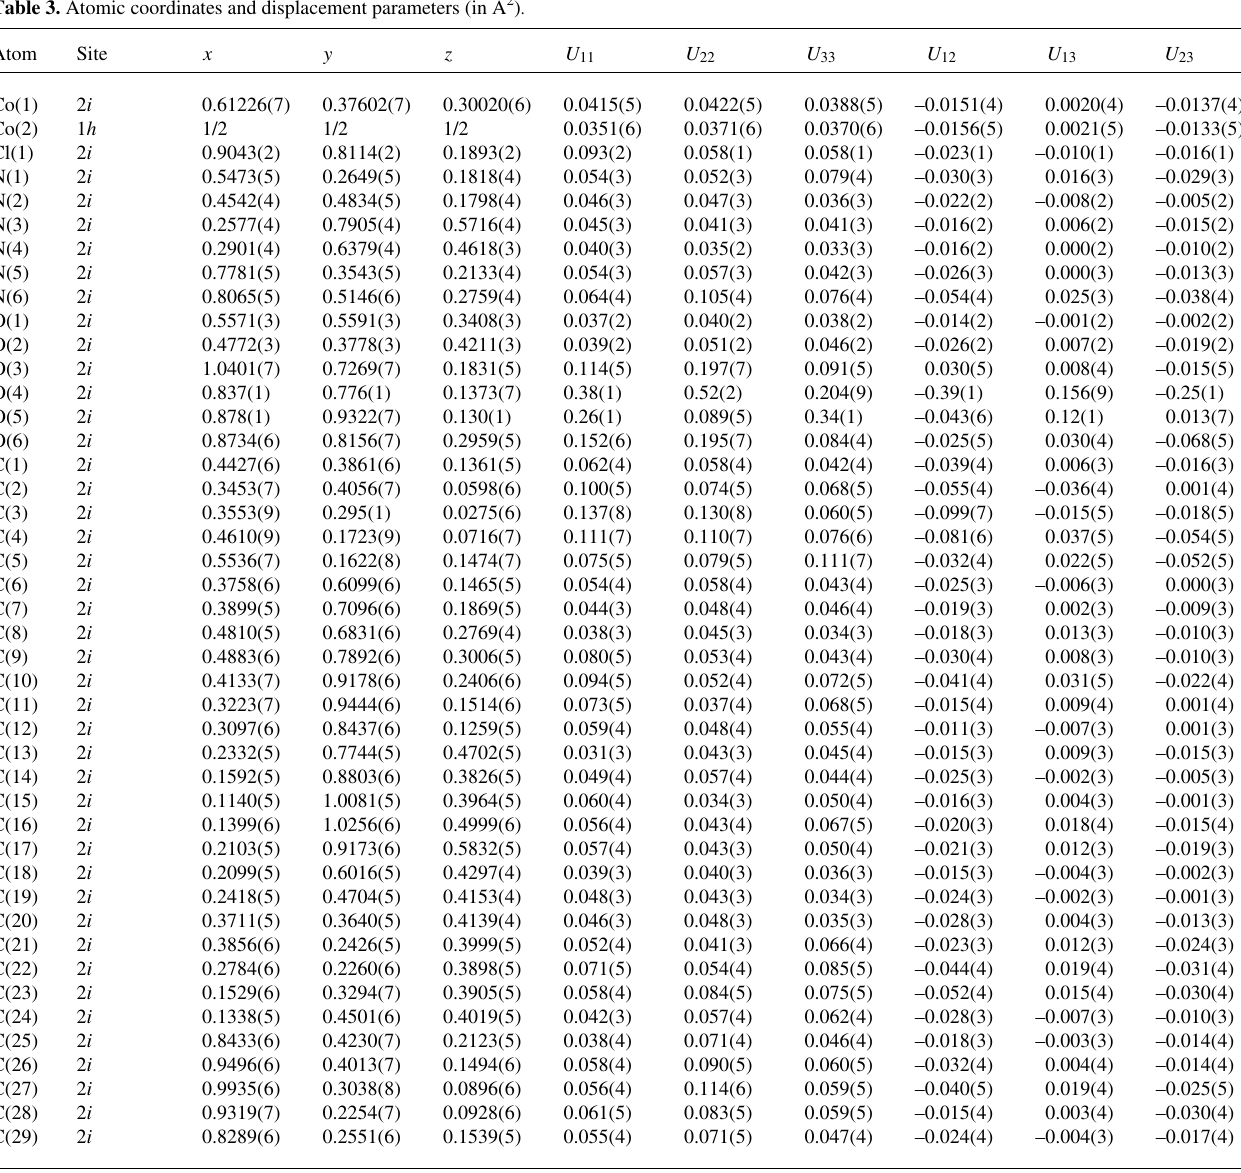
Table 3. Atomic coordinates and displacement parameters (in Å 2 ) .